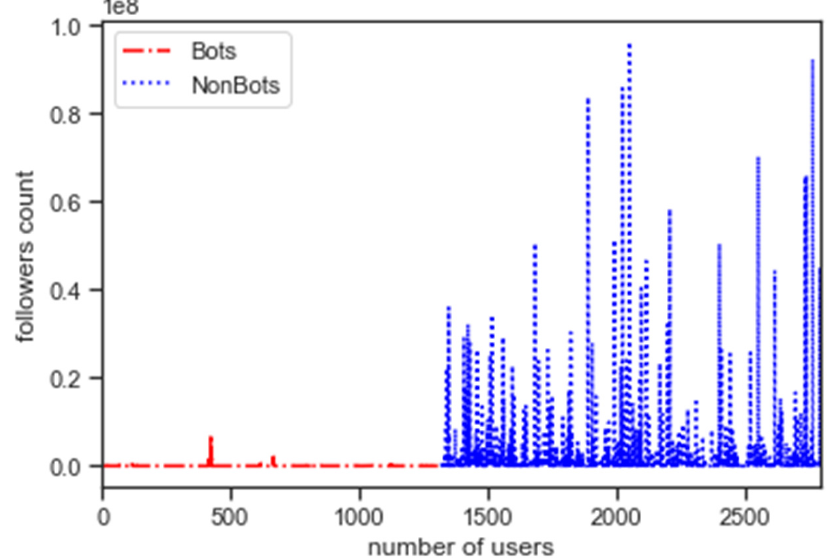
Figure 11. Numbers of Users with Different Follower Count .